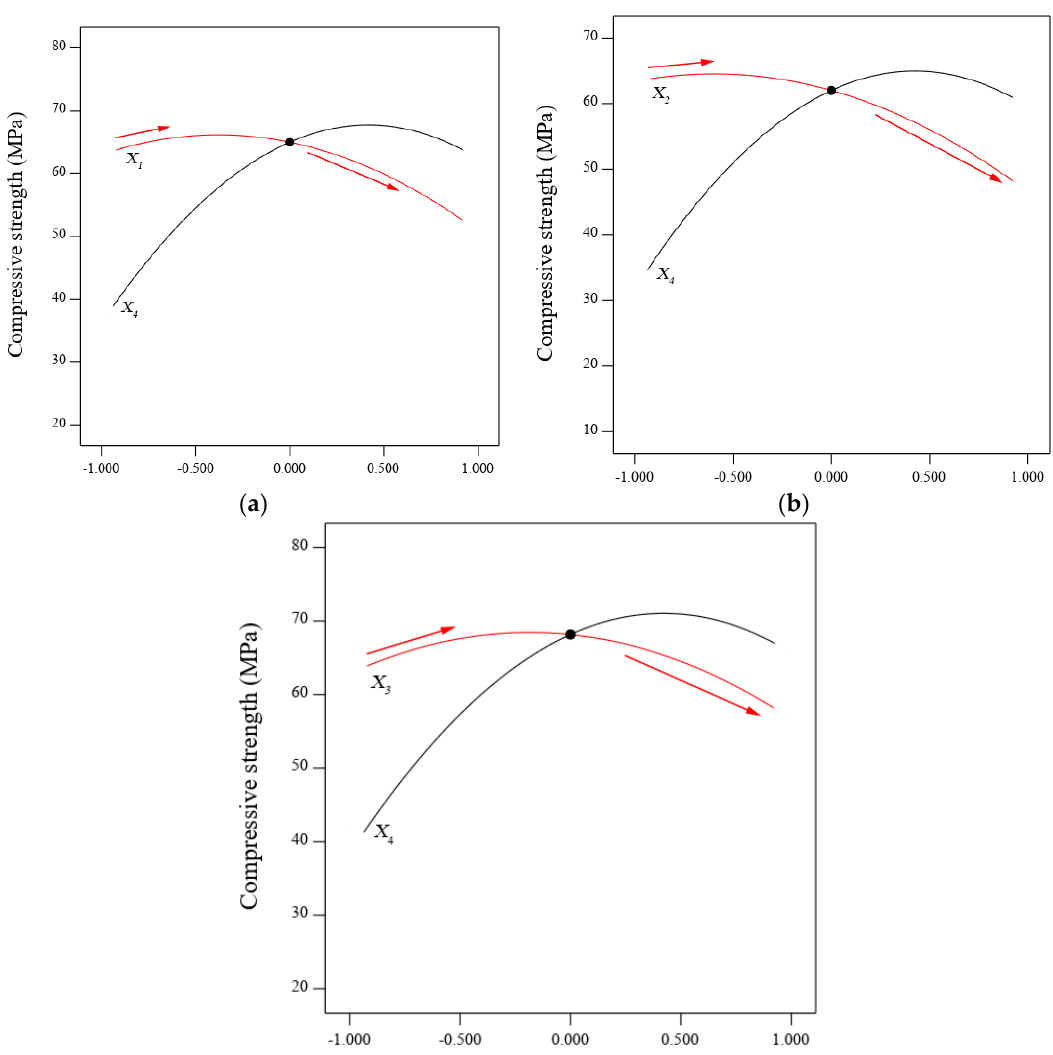
Figure 6. Interactions of BGWNP addition ( a ) at constant FA-GBFS ratio (Model 1), ( b ) as the replacement of GBFS (Model 2), and ( c ) as the replacement of FA (Model 3).